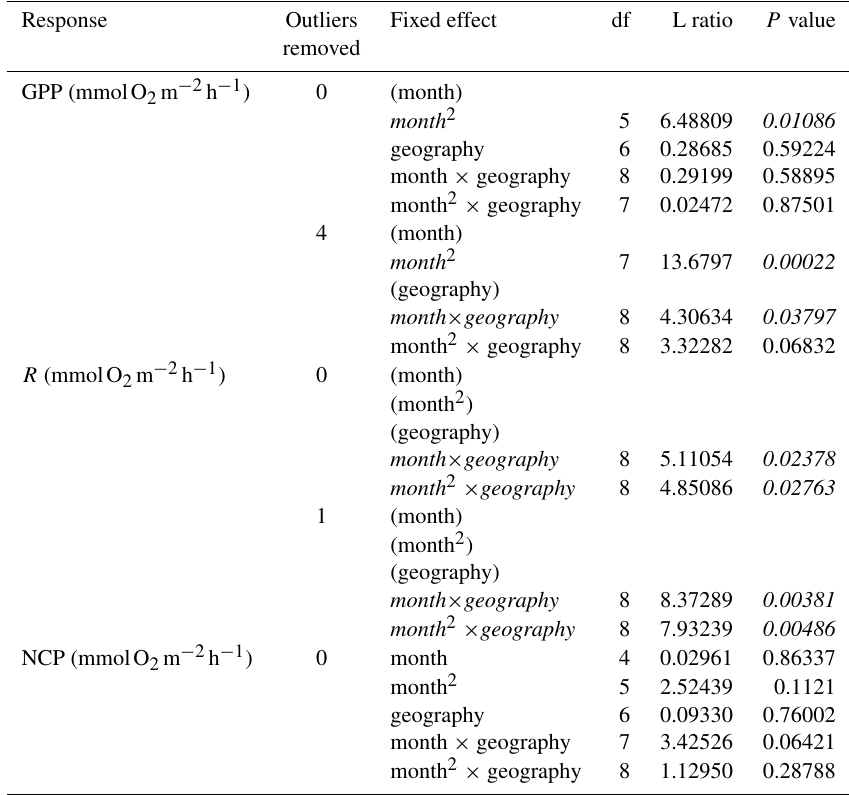
Table 1. Statistics for linear mixed-effects models of hourly rates of O 2 fluxes. Terms in parentheses were removed from the final model using backward model selection.